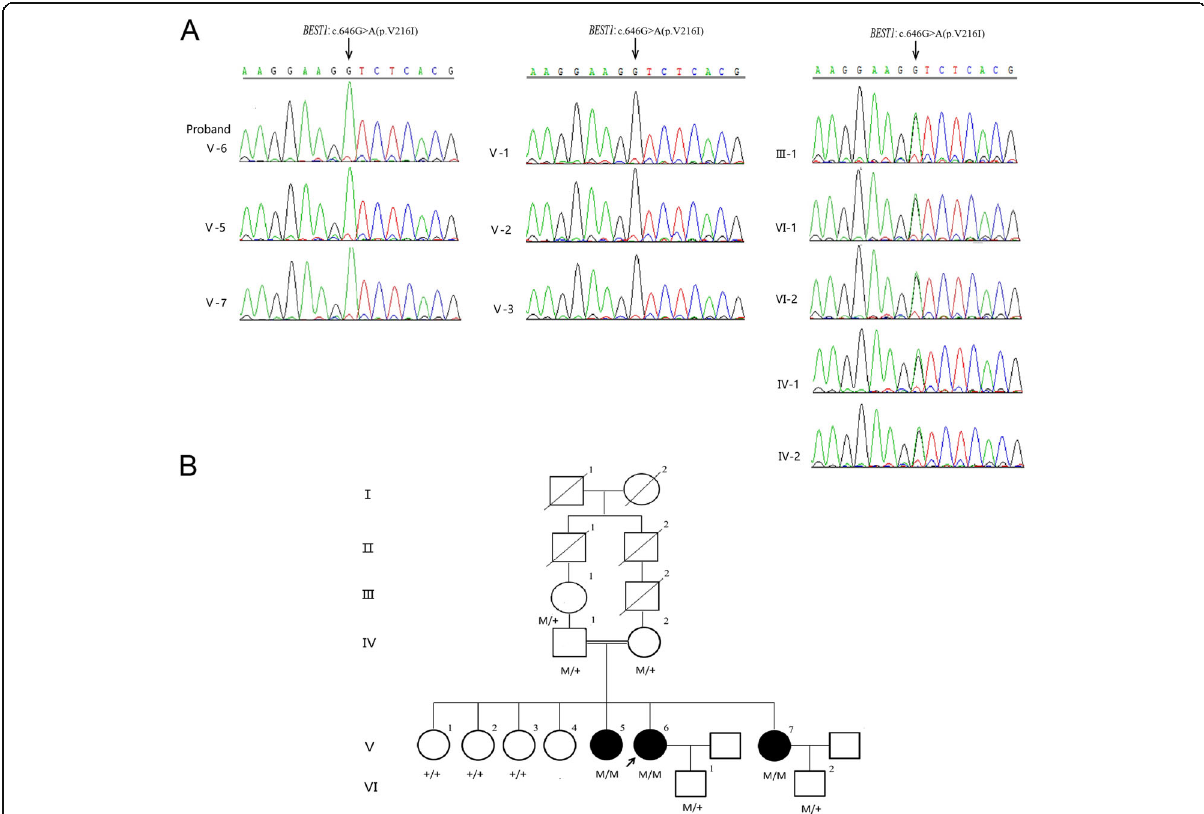
Fig. 2 A novel autosomal recessive mutation in the BEST1 gene c.646G > A (p.V216I) was identified in the family. a The results of family separation and analysis showed that the proband (V6), her fifth sister (V5), and her younger sister (V7) carry the homozygous variation. The grandmother (III-1), father (IV1), mother (IV2), and son (VI1) of the proband, her fourth sister (V4), and the son (VI2) of her younger sister carry the heterozygosity. The first sister (V1), the second sister (V2), and the third sister (V3) of the proband carry the wild-type gene. b Pedigree. Square symbols denote males, circle symbols denote females, solid symbols indicate the affected, open symbols indicate the unaffected, slash symbols indicate the deceased, an arrow below the symbol indicates the proband, = indicates consanguinity, and + indicates the wild